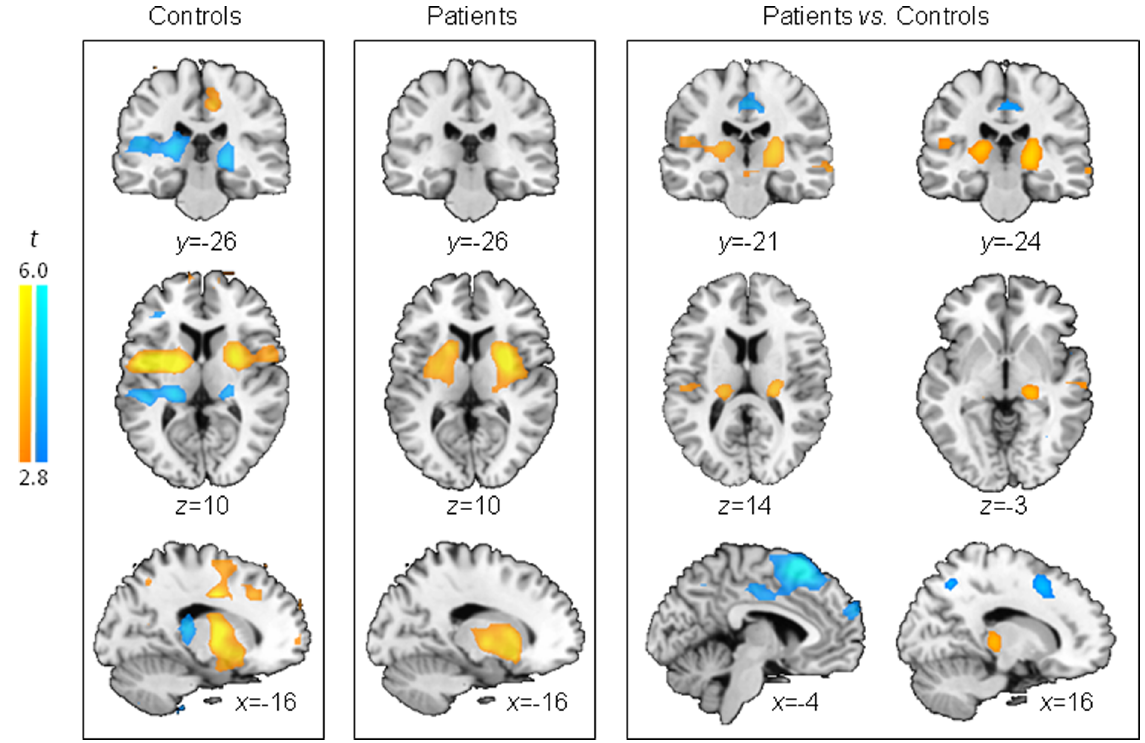
Figure 2. Functional correlations of left amygdala across participants. Brain regions in which rGMR correlates positively (orange colors) or negatively (blue colors) with the amygdala rGMR across participants: controls ( left ), patients ( middle ), and difference between the groups ( right ). Compared to controls, patients had stronger correlations (orange) between the amygdala and the thalamus-hippocampus and weaker correlations (blue) with the medial prefrontal cortex across conditions. Maps are thresholded at p=0.005 and 10 adjacent voxels.